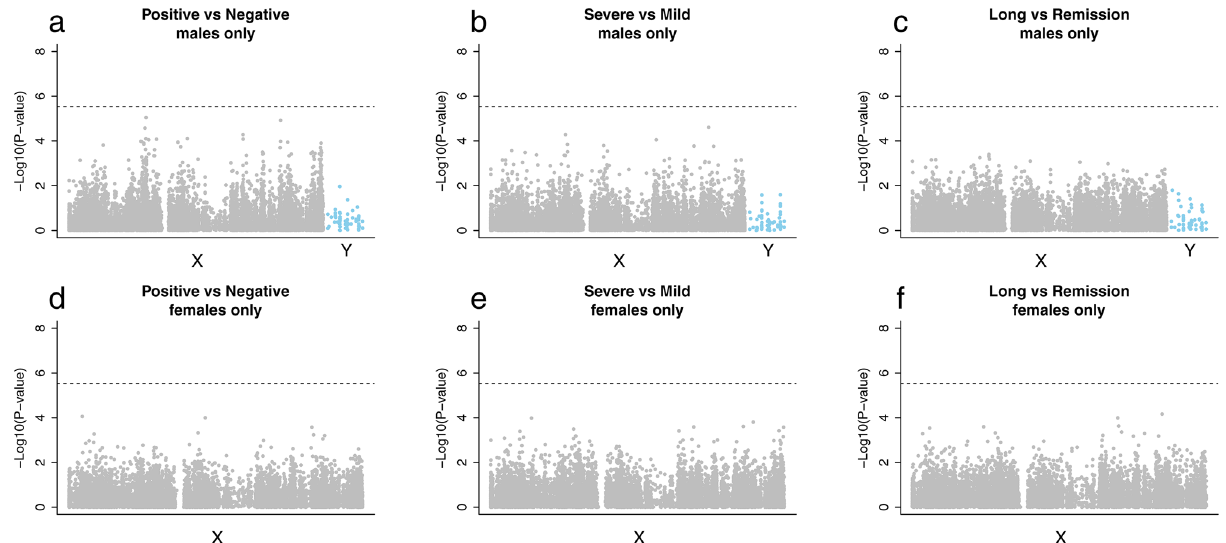
Figure 5. Manhattan plots for the sex-stratified EWASs of probes on the sex chromosomes. The plots display the association statistics at each of the 17,183 X-chromosome probes and 51 Y-chromosome probes (indicated by blue dots). The upper panels ( a ) to ( c ) are for males only (including the Y-chromosome probes), and the lower panels ( d ) to ( f ) are for females only (X-chromosome probes only). Panels ( a ) and ( d ) display the result of the comparison between COVID-19 positive and COVID-19 negative. Panels ( b ) and ( e ) show the results of the comparison between severe COVID-19 and mild COVID-19. Panels ( c ) and ( f ) show the results of the comparison between long-COVID and remission. The dotted line indicates the Bonferroni threshold (0.05/17,183 CpG sites).